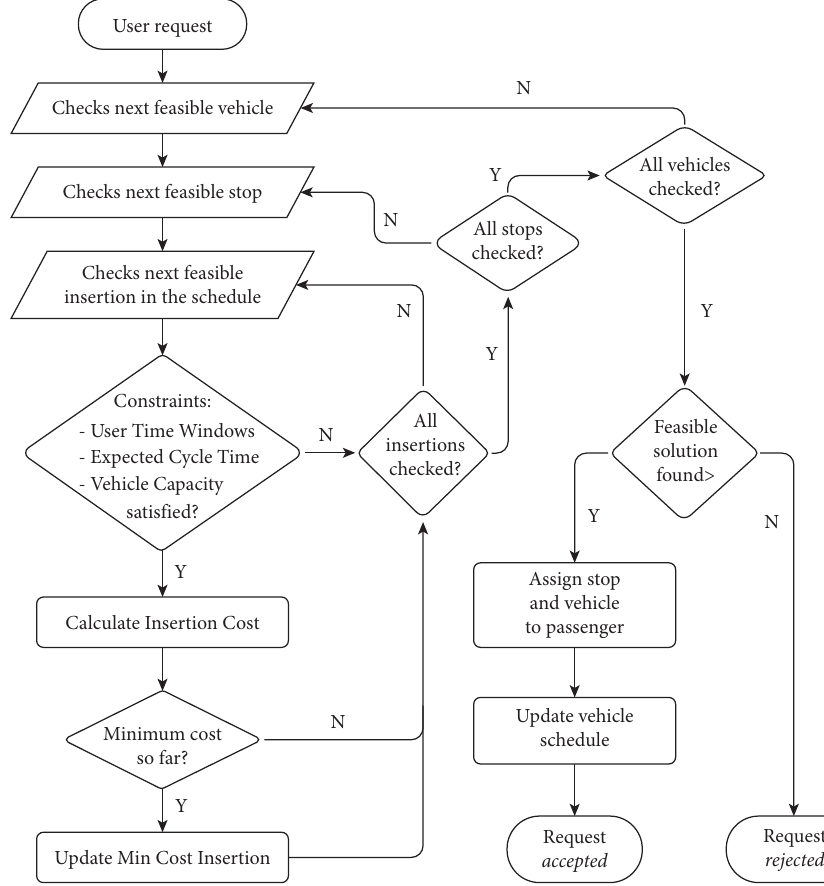
Figure 5: Flowchart of the dispatching algorithm for the DRF